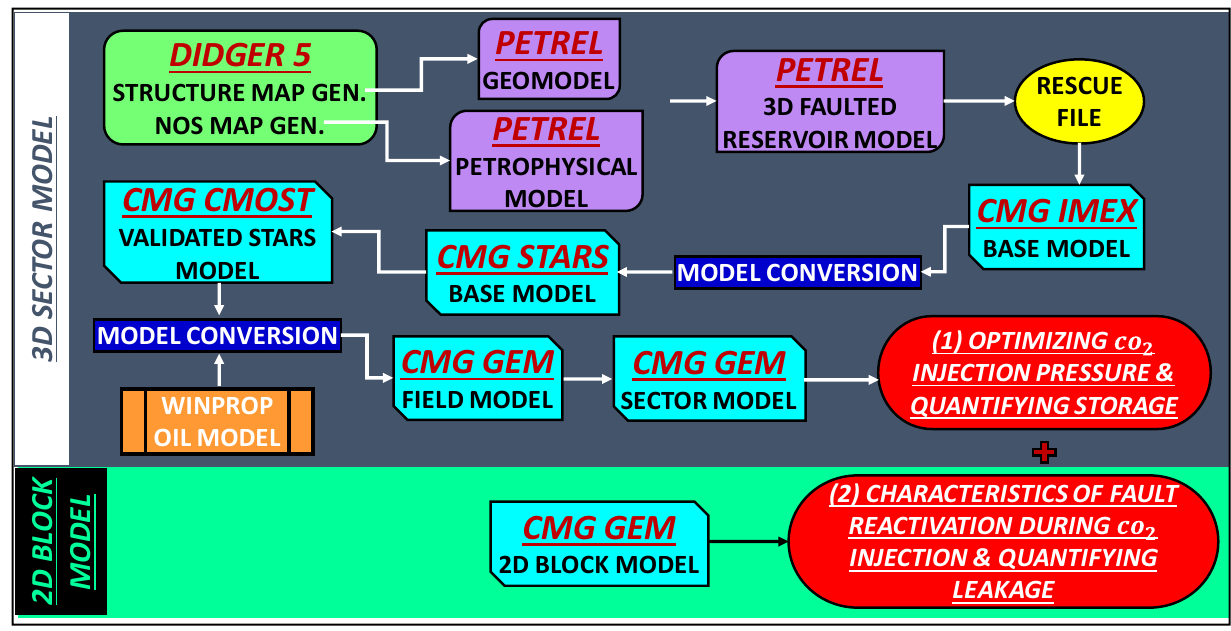
Fig. 8 Methodology workflow implemented within the